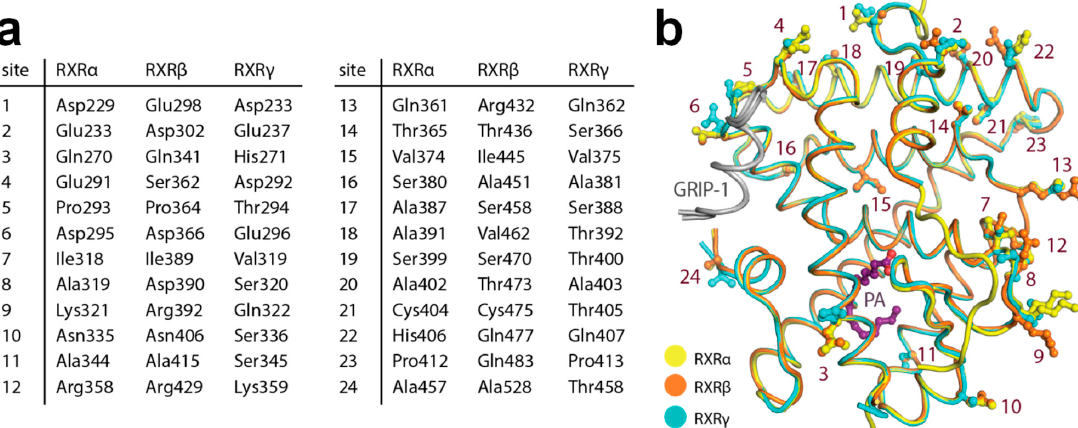
Figure 4. Amino acid differences within the ligand-binding domain (LBD) of the three RXR isoforms. ( a ) Summary of the residue differences. ( b ) Mapping of the substitutions onto the RXR structure with the numbering scheme according to ( a ).